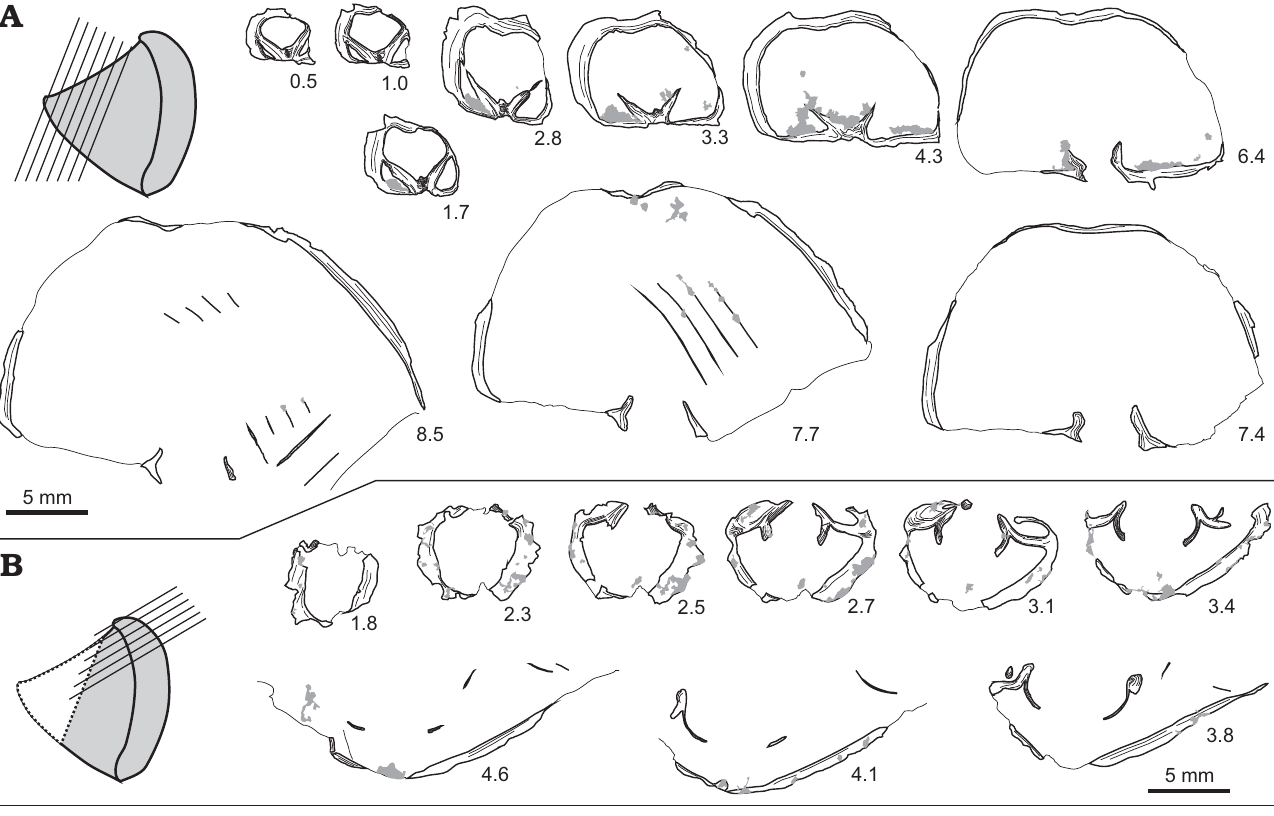
Fig. 3. Transverse serial sections of spiriferide brachiopod Thomasaria simplex (Phillips, 1841) through shell NHMUK PI B 2807 (topotype) from the Givetian of Wolborough, England, UK. Sections through ventral ( A ) and dorsal ( B ) valves. The schematic drawings on the left of each section describe the direction of sectioning (see text). Distances measured in millimetres from the tip of the ventral and dorsal umbos, respectively. Gray areas denote local